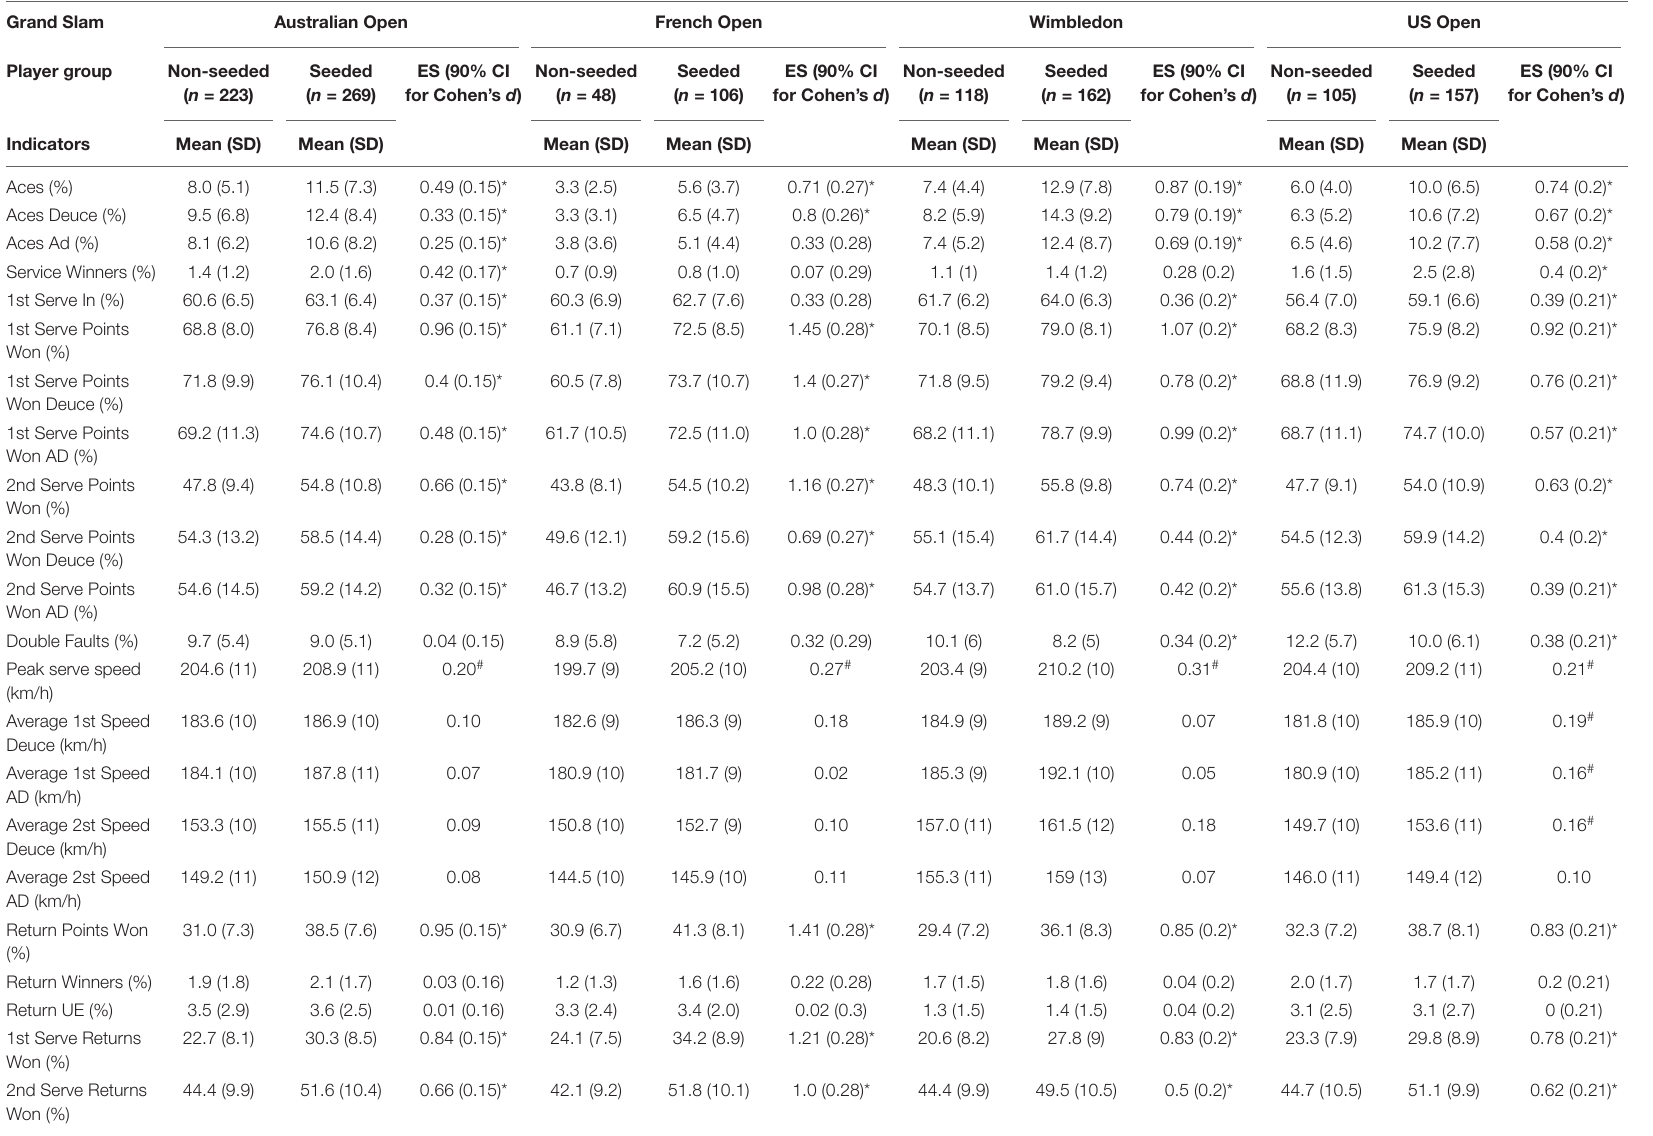
TABLE 3 | Descriptive statistics and comparisons of serve and return performance indicators for seeded and non-seeded players during Grand Slams. Grand Slam Australian Open French